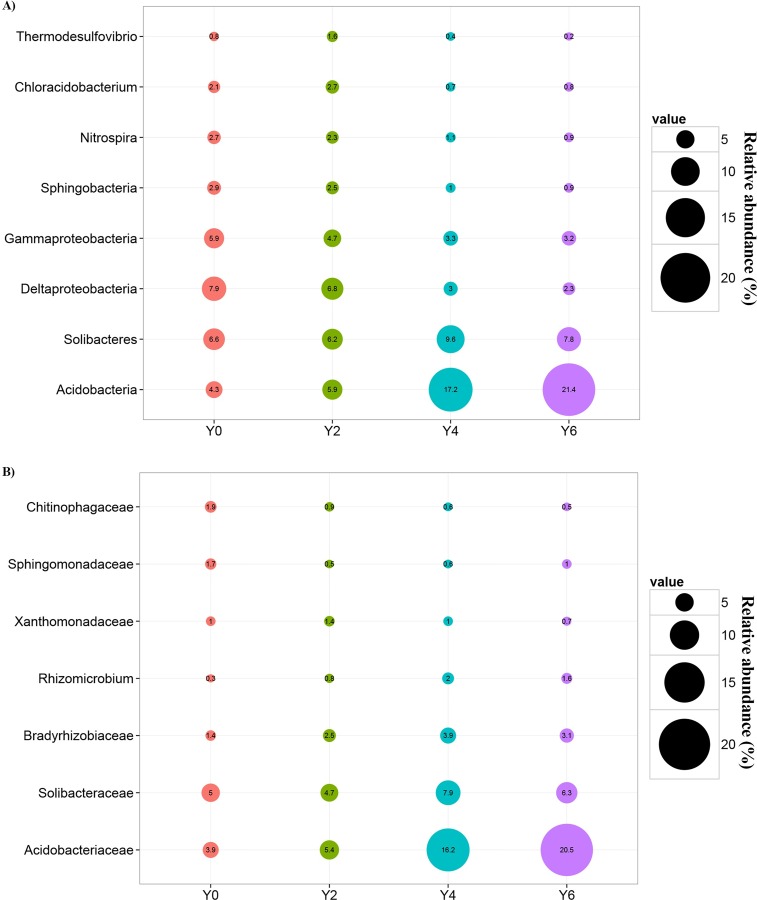
Changes in bacterial populations over years of cultivation.Bubbles represent the average relative abundances of bacterial populations at the class level (A) and the family level (B). 2-year-old (Y2, n = 6), 4-year-old (Y4, n = 12), 6-year-old (Y6, n = 9), and non-cultivated (Y0, n = 3) soil samples. All bacterial populations showed significant differences between cultivation times with p<0.05 (one-way ANOVA, post hoc Tukey’s test).